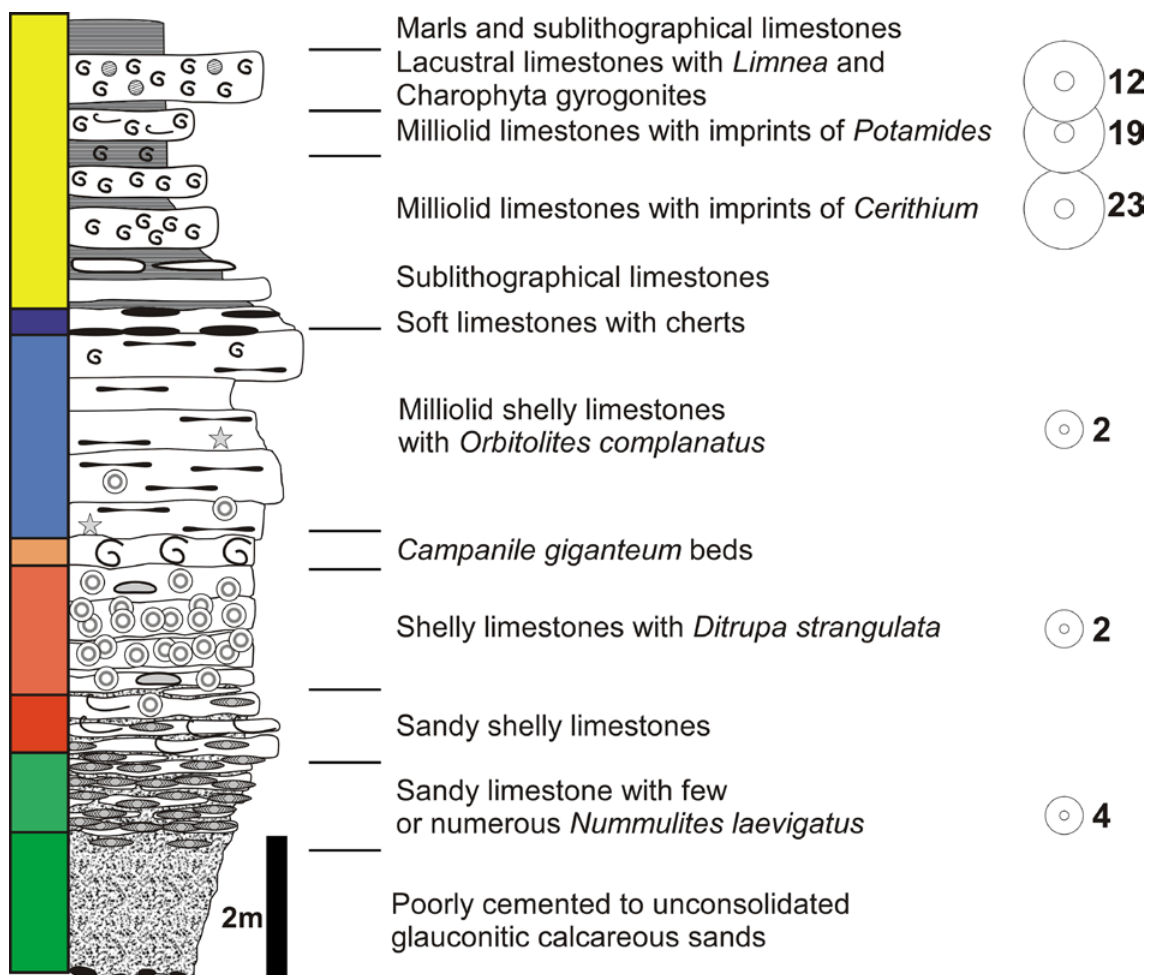
Figure 8. Columnar section of the Lutetian limestones layers from the area of Reims and, to the right, the respective quantities of rotary querns from the Late Iron Age (La Tène) settlement of Acy-Romance, Ardennes, France (Buchsenschutz et al . 2017).